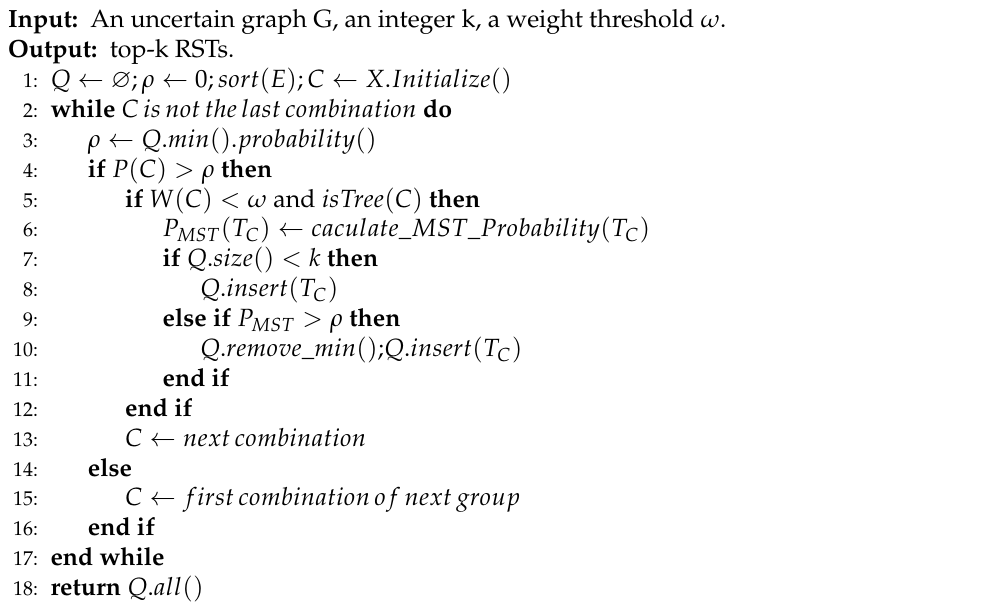
Algorithm 3. The Edge Filtering Algorithm On The Fly,